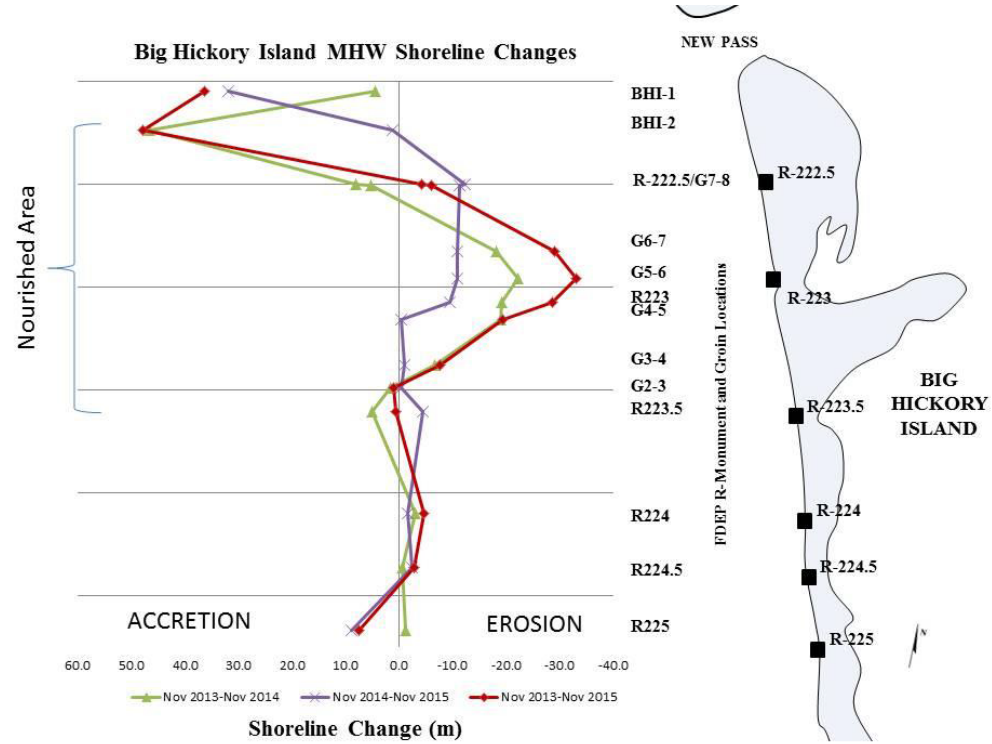
Figure 7. Time-series Mean High Water (MHW) shoreline changes at FDEP R-monuments and groin locations (Nov 2013–Nov 2014; Nov 2014–Nov 2015; Nov 2013–Nov 2015). Figure 6 illustrates shoreline position, whereas this figure quantifies the change.